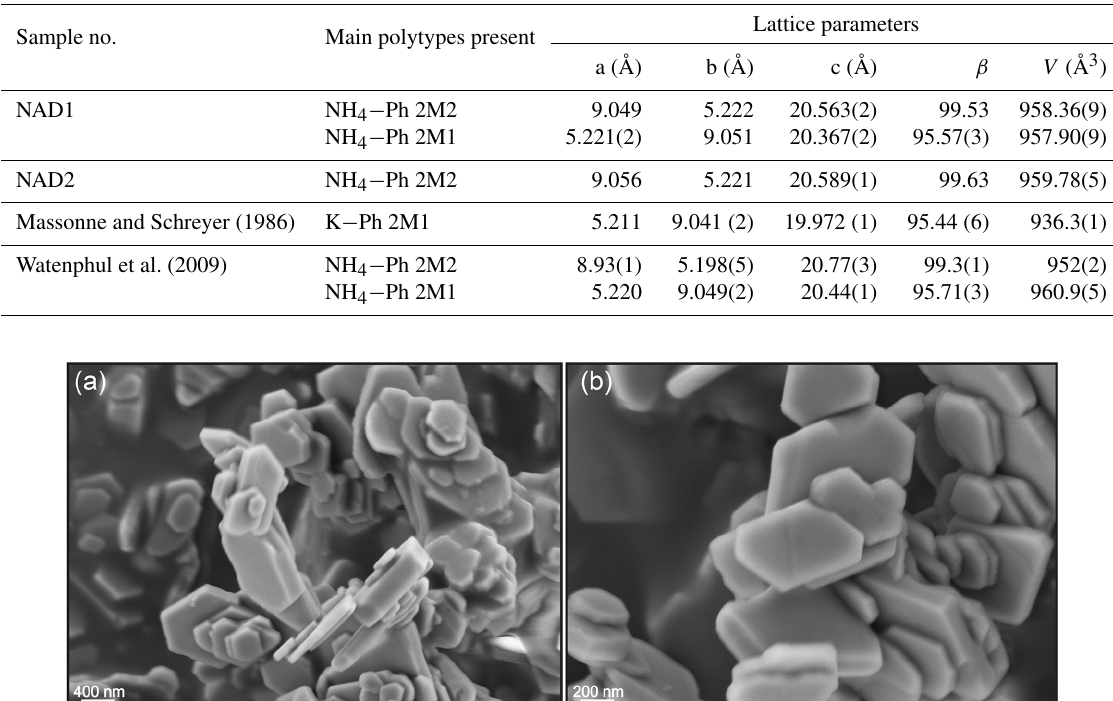
Table 1. Lattice parameters of the main NH 4 -phengite (Ph) polytypes produced in different runs (NAD1 and NAD2), calculated from Rietveld refinements. Limited quantities of other polytypes (3T, 2Or and 1M) are also present together with traces of kyanite and coesite. Lattice parameters of NH 4 -Ph polytypes produced by Watenphul et al. (2009) as well as a K analogue by Massonne and Schreyer (1986) are shown for comparison. Mineral abbreviation is used following Whitney and Evans (2010).